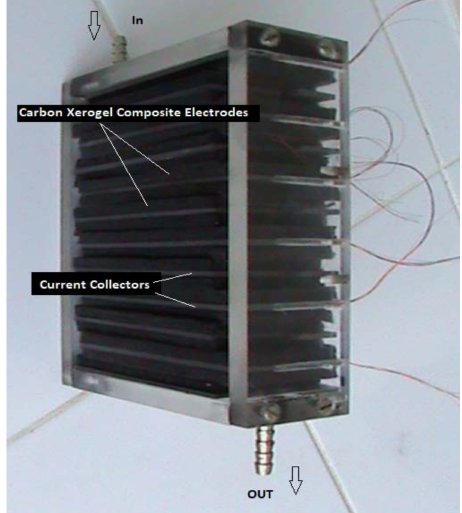
Figure 20. Cross image of the CDI stack module-based CX type nanowhisker